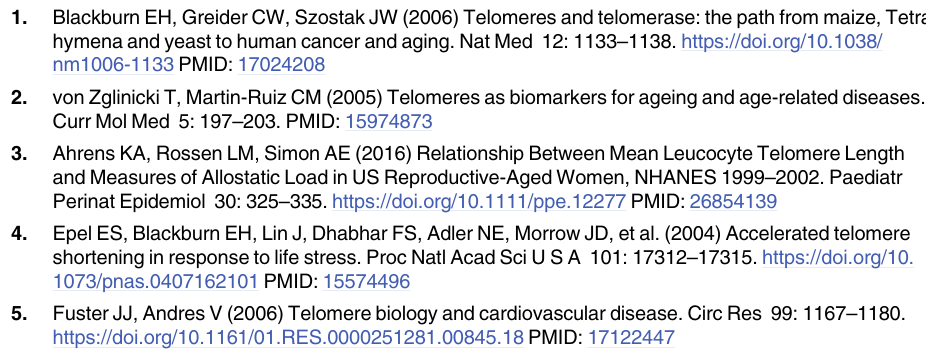
S1 Table. Comorbid conditions included in Charlson’s comorbidity index. S2 Table. Multivariable regression for factors associated with telomere length- NHANES 1999–2002. S3 Table. Multivariable regression for women’s reproductive history associated with telo- mere length- NHANES